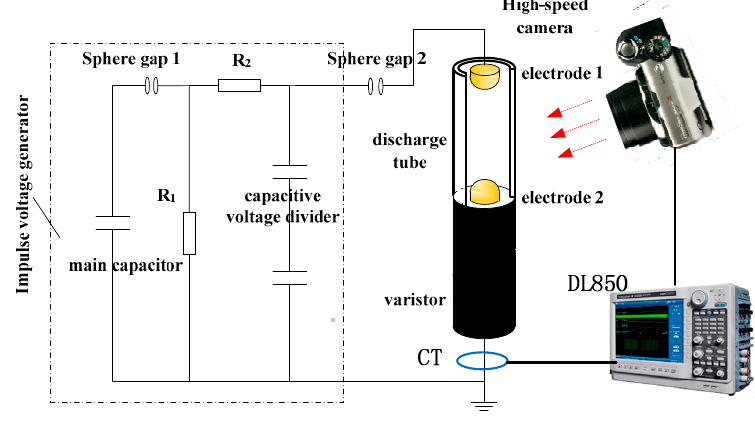
Figure 1. Test circuit of impulse voltage.